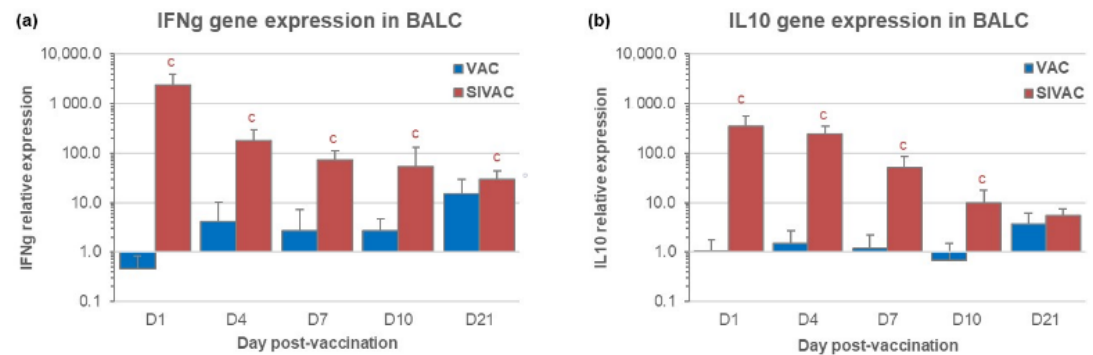
Figure 5. Relative gene expression assessed by RT-PCR in BALCs from the SIVAC and VAC groups for ( a ) IFNg or ( b ) IL10 using expression results obtained in the UNVAC group as the reference. Data are reported as the mean ( ± SD) of the results obtained from all piglets in each group. Letter (c) indicates that the SIVAC group was significantly different from the VAC group with p < 0.05.